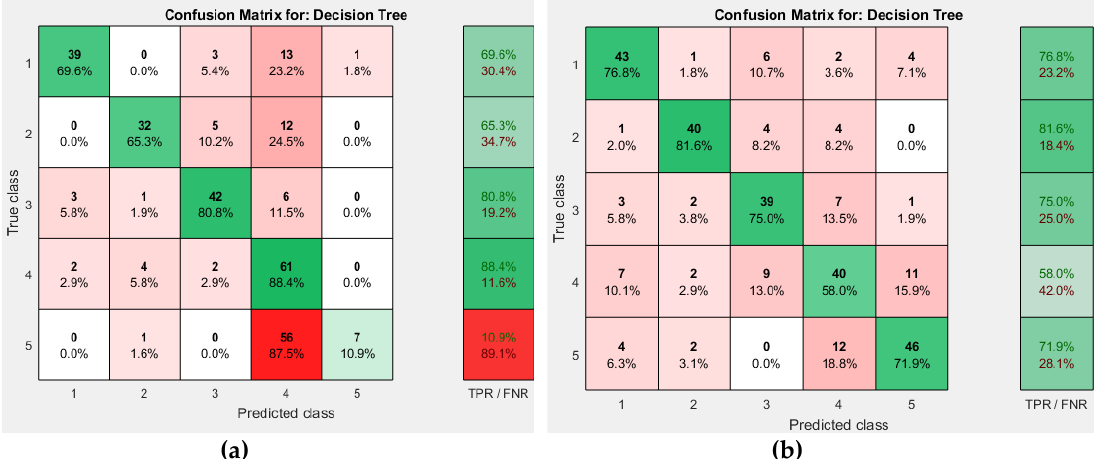
Figure 9. Decision Tree Confusion Matrix. ( a ) Simple Tree ( b ) Medium Tree.